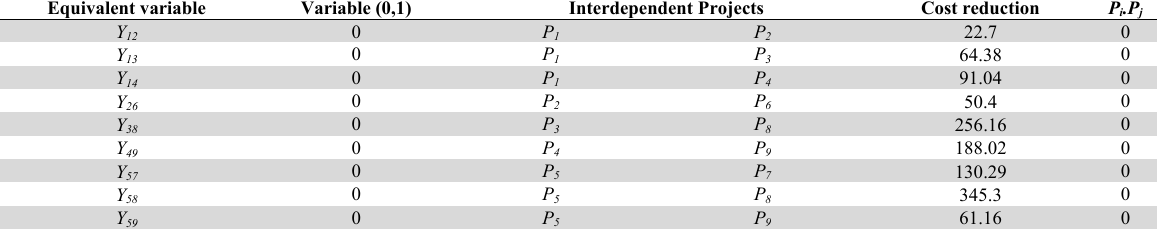
Variables of the problem related to project cost synergies in a numerical example Equivalent variable